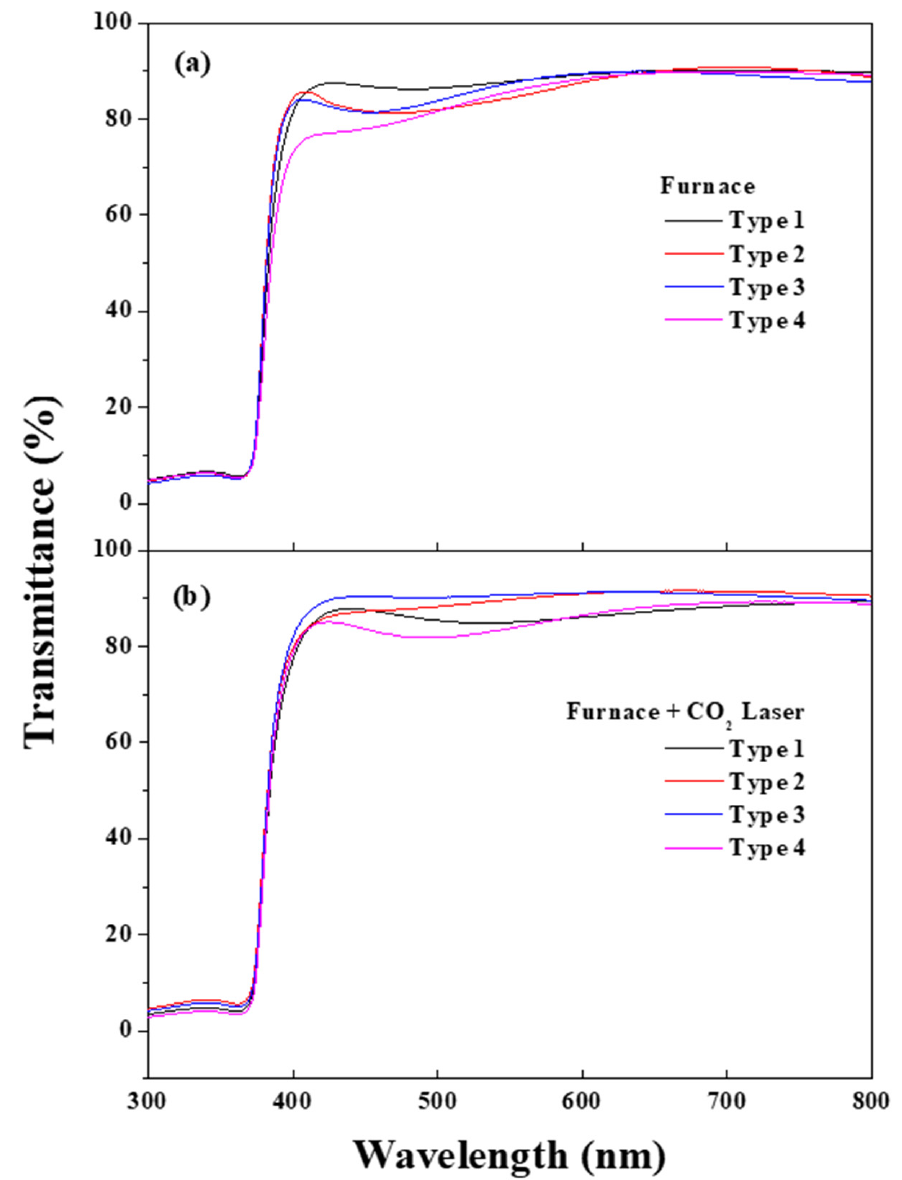
Figure 6. Optical transmittance of 4 types of (In, Ga) co-doped multilayered thin films after electrical furnace ( a ) and furnace & CO 2 laser annealing ( b ).